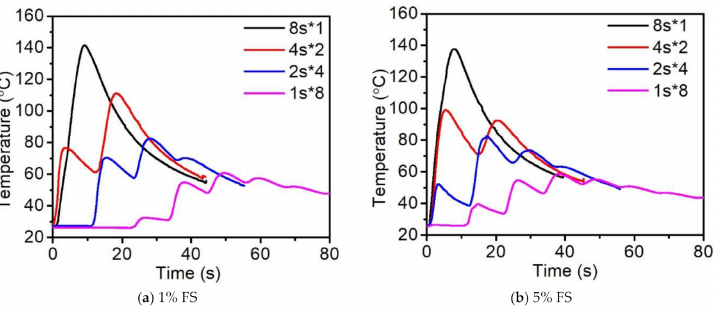
Figure 5. Effects of fumed silica amount and curing strategies on the reaction heat temperature.